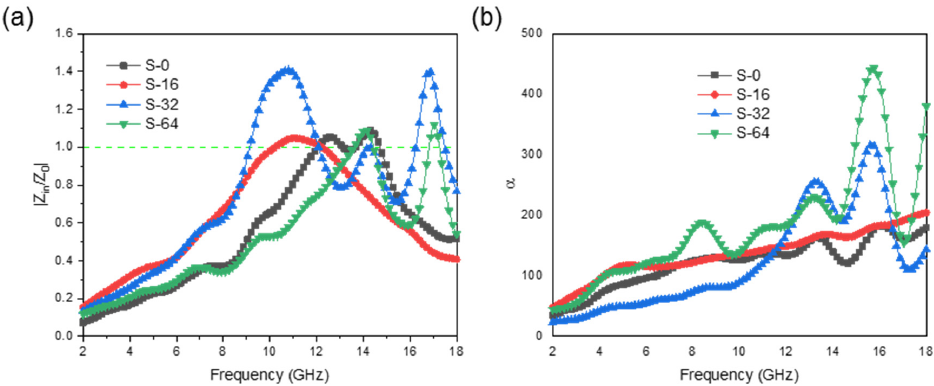
Figure 6. Impedance matching ( a ) and attenuation constant ( b ) of Co-Ni/C composites. Table 1. Comparison of microwave absorption properties of microwave absorbers in this work with other reported MOF-derived microwave absorbers.